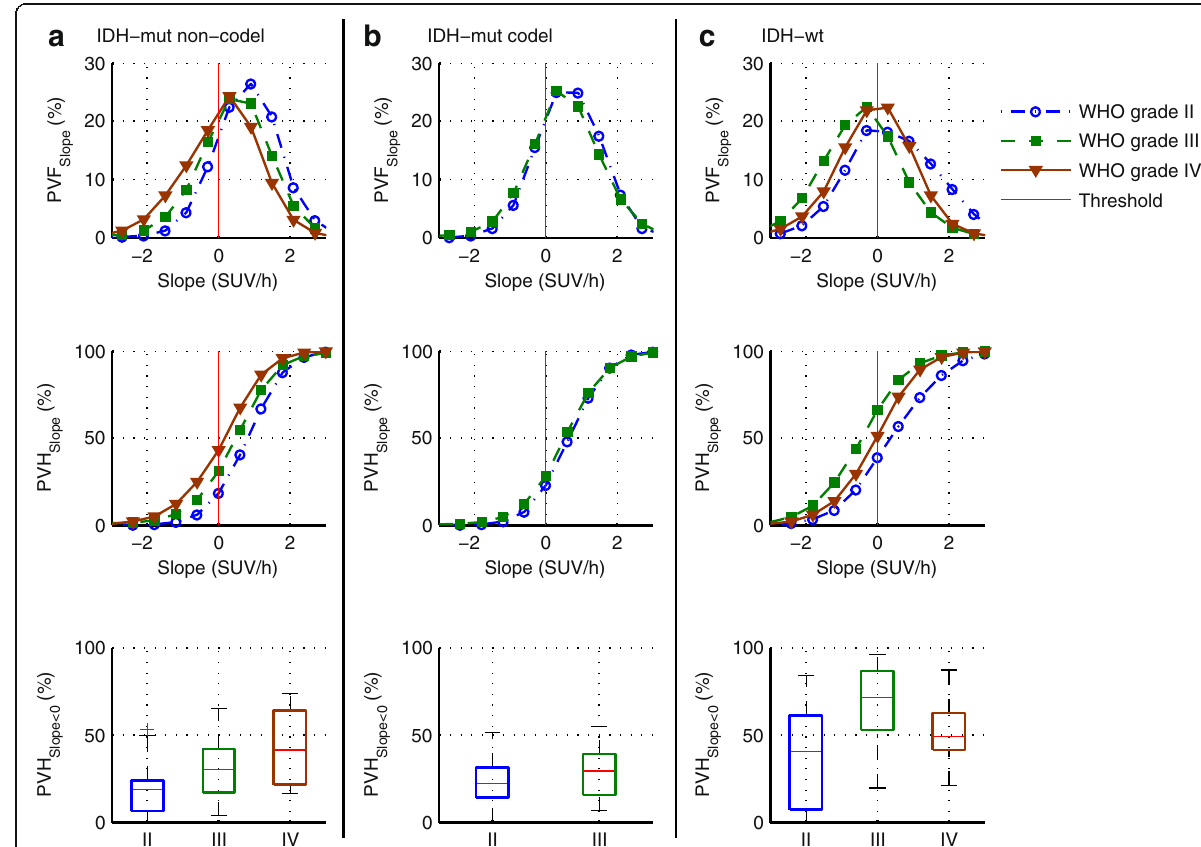
Fig. 3 Data presented as in Fig. 2, with average percentage volume fractions of the slope (PVF Slope ), the corresponding cumulated histograms (PVH Slope ), and the boxplots of PVH data with slope < 0 SUV/h (PVH Slope<0 SUV/h ). a IDH -mut non-codel. b IDH -mut codel. c IDH